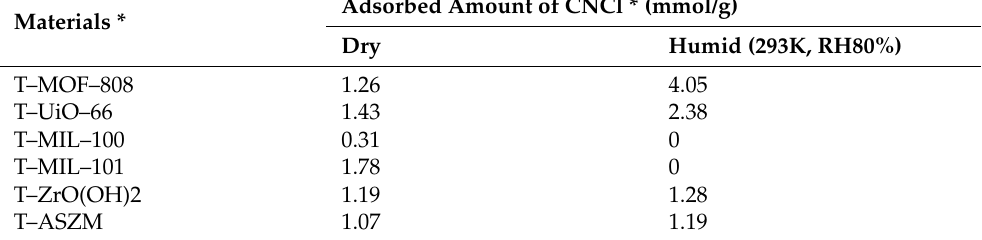
Table 2. CNCl capacities of MOFs [37].